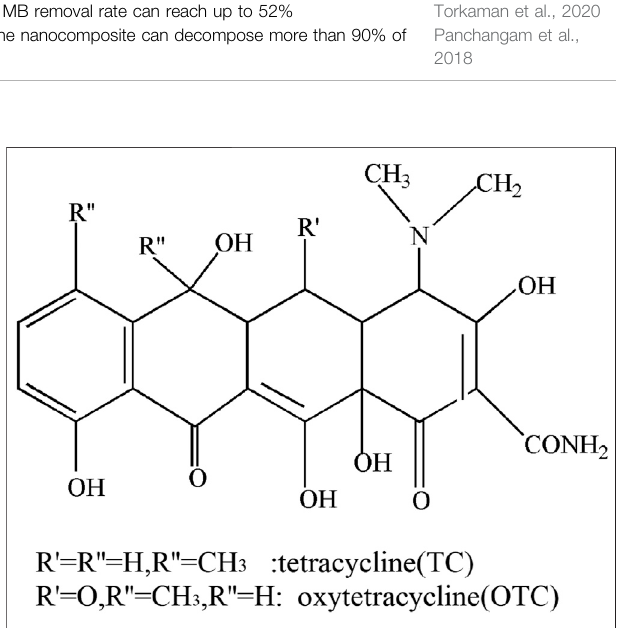
FIGURE 6 | Schematic diagram of